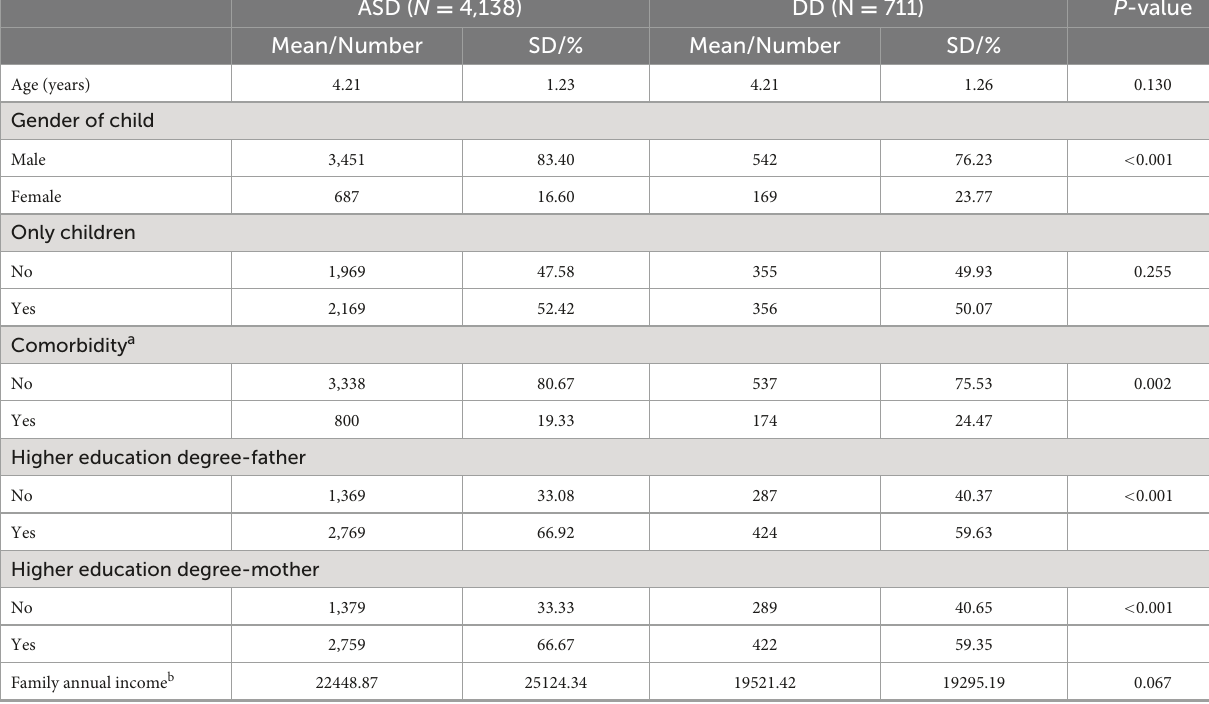
TABLE 1 Characteristics of ASD and DD